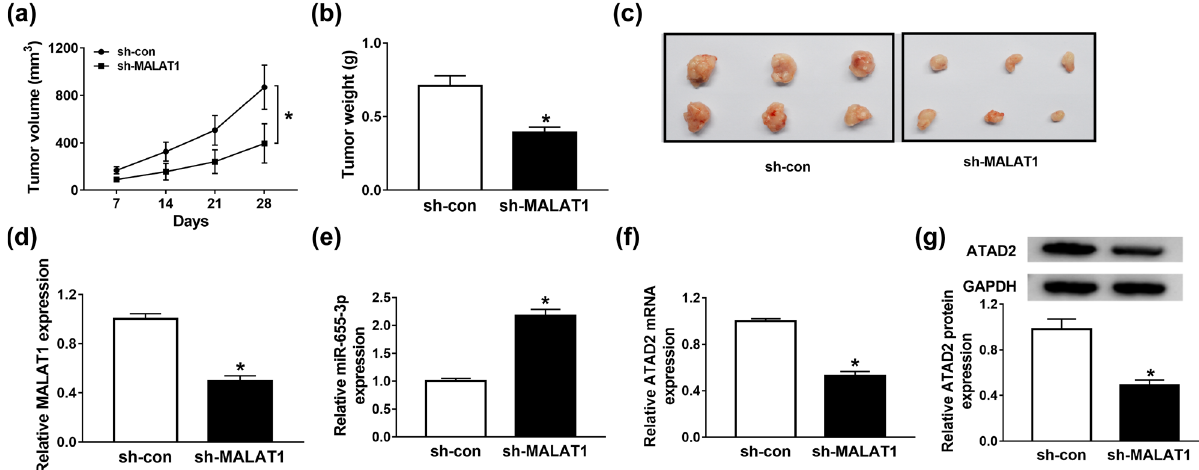
Figure 7: MALAT1 depletion impeded xenograft tumor growth in vivo . ( a – g ) The nude mice were injected with stable Y79 cell line expressing shRNA against MALAT1 or negative control. ( a ) The tumor volume was examined every 7 days for 28 days. ( b ) 28 days post - injection, the mice were executed, and tumors were removed and weighed. ( c ) Images of mice with subcutaneous transplanted tumors. ( d – f ) The expression levels of MALAT1, miR - 655 - 3p, and ATAD2 in transplanted tumors were detected via RT - qPCR. ( g ) The protein level of ATAD2 in transplanted tumors was detected via western blot assay. * P <